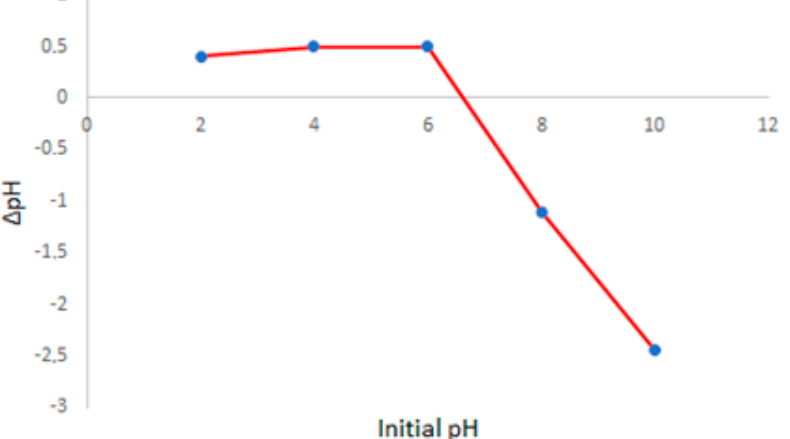
Figure 6. pH PZC calculated for polyimide nanofiber under pH variation for 2.0 mg of nanofiber.